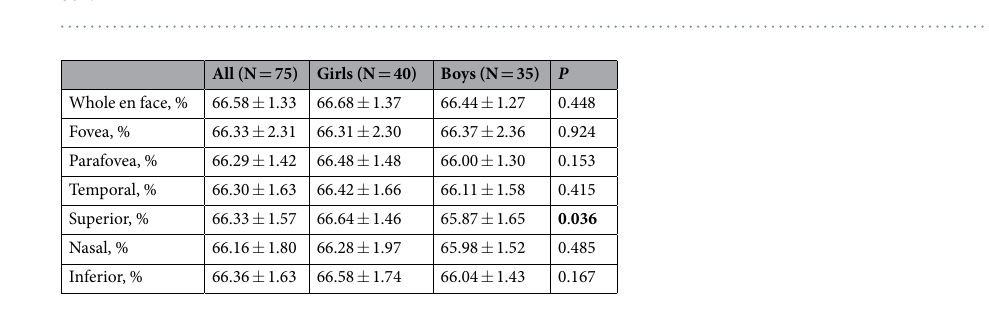
Table 4. Mean vascular flow density in the choriocapillaris measured by OCT angiography according to sex.